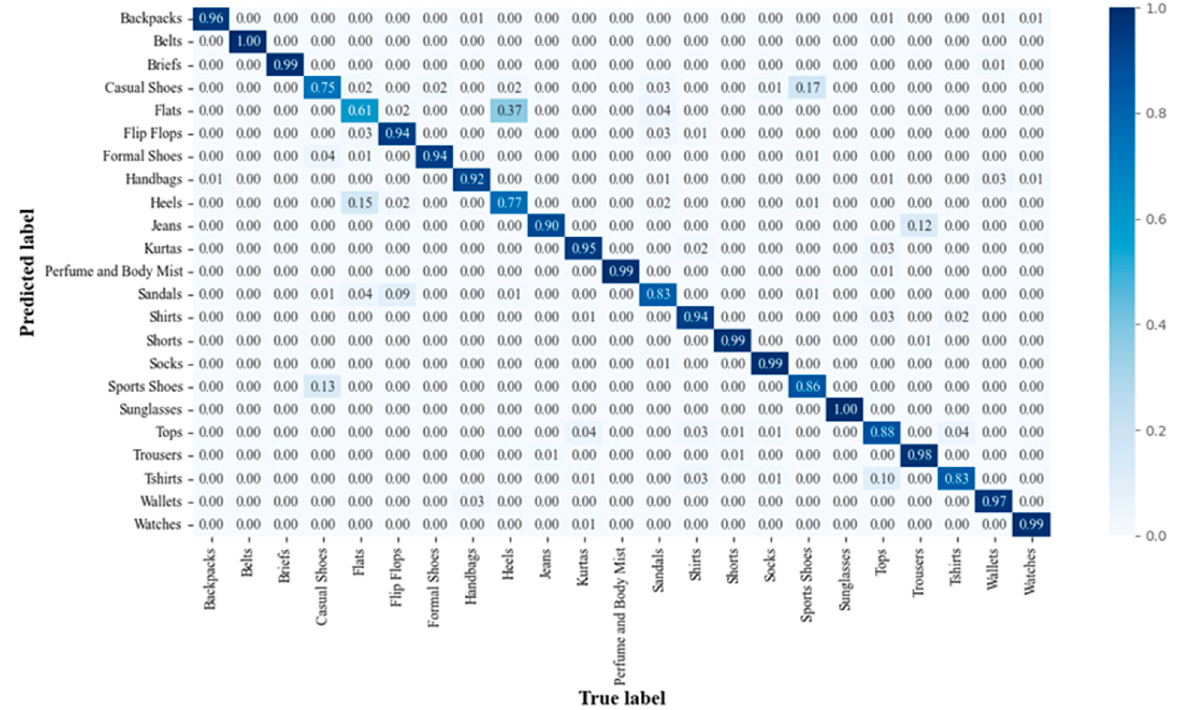
Figure 6. Confusion matrix from classification.